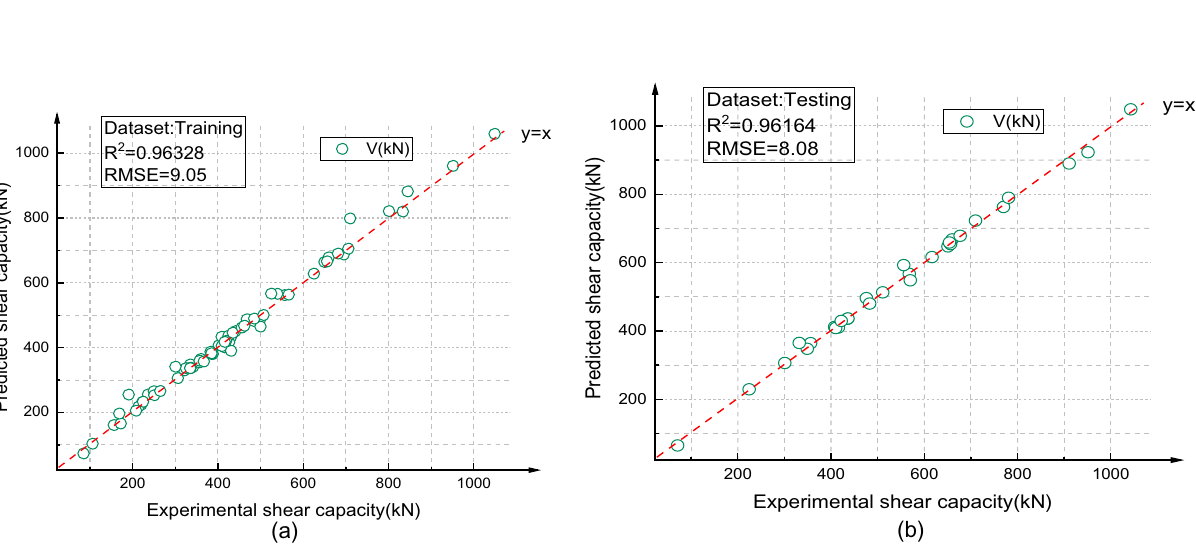
Figure 16. BPNN (6-15-8-1) prediction results {( a ) Training set, ( b ) Testing